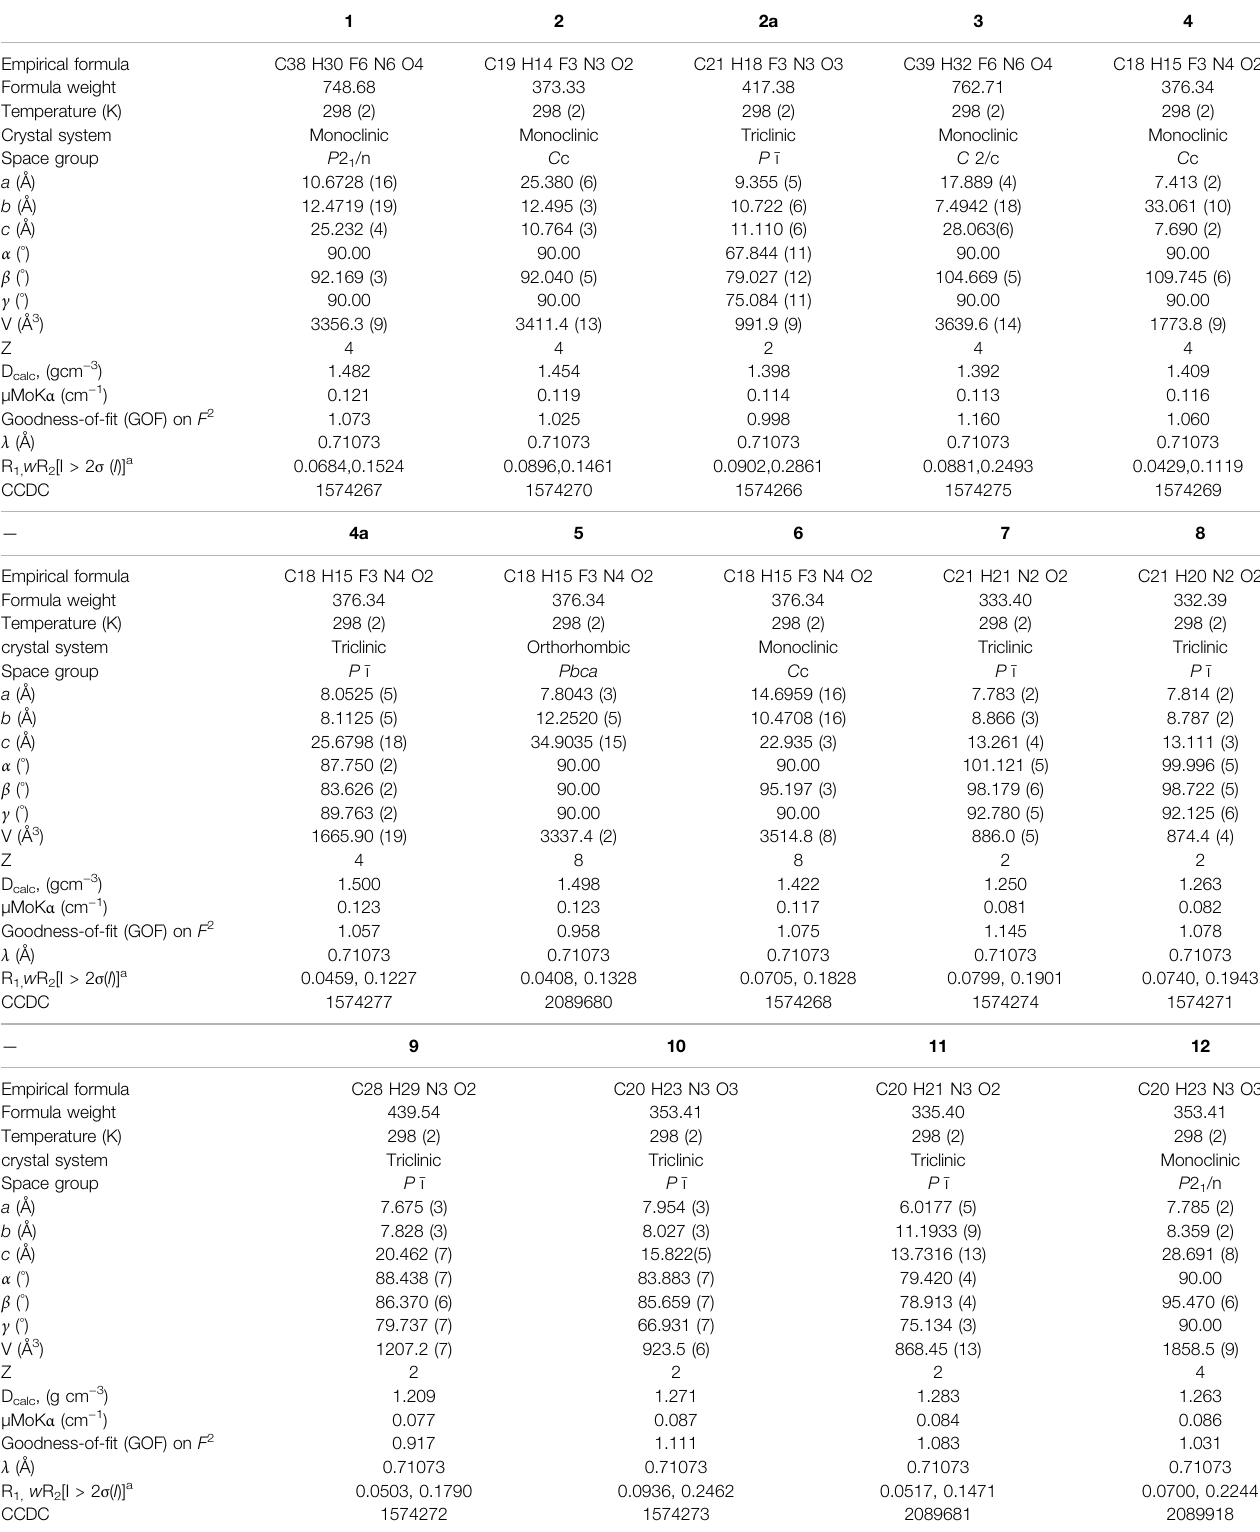
TABLE 2 | Crystal data and structure re fi nement of the solids 1 ‒